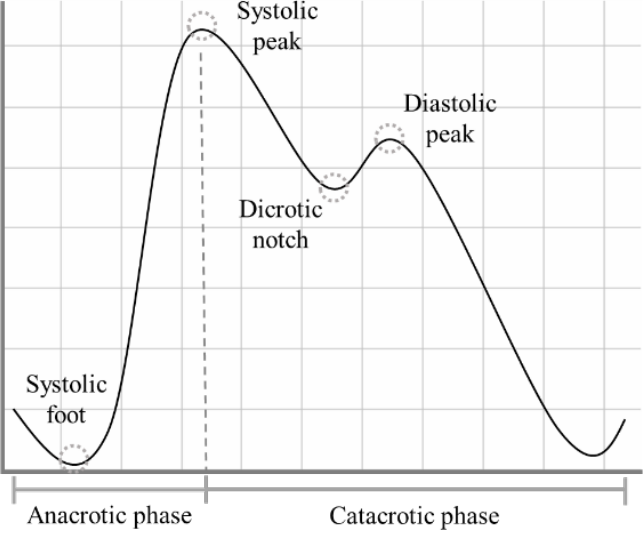
Figure 1. The shape of a typical PPG pulse.